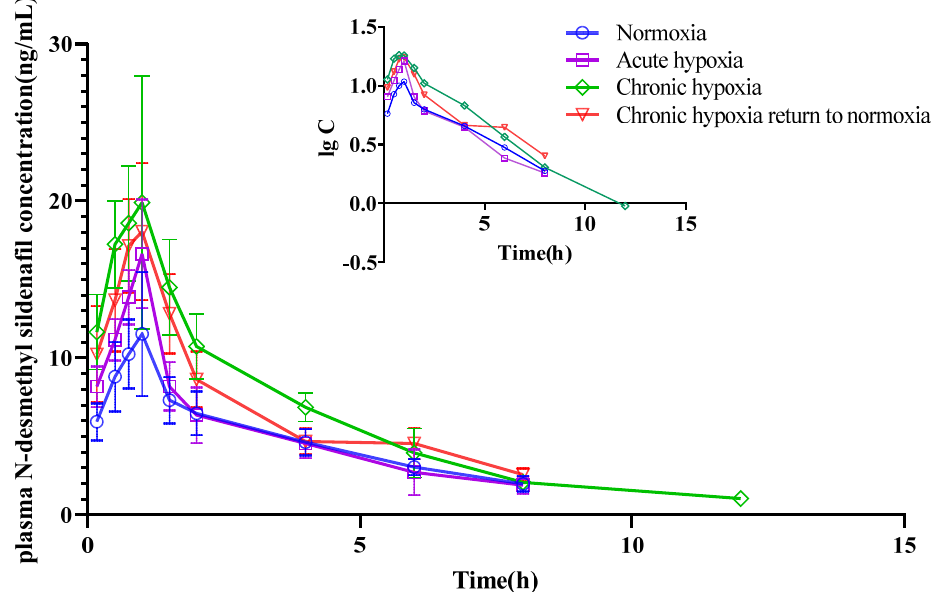
Figure 7. Mean plasma concentration time curve of N-desmethyl sildenafil for rats after exposure to high-altitude hypoxia ( n = 8).